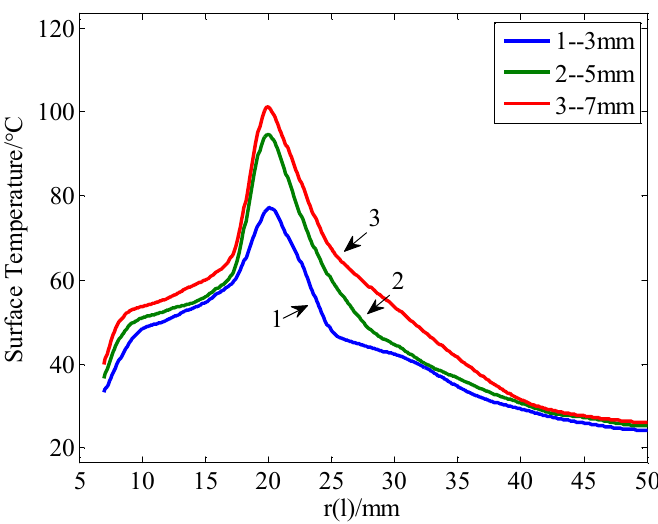
Figure 10. Influence of dry band width on the surface temperature of insulators.